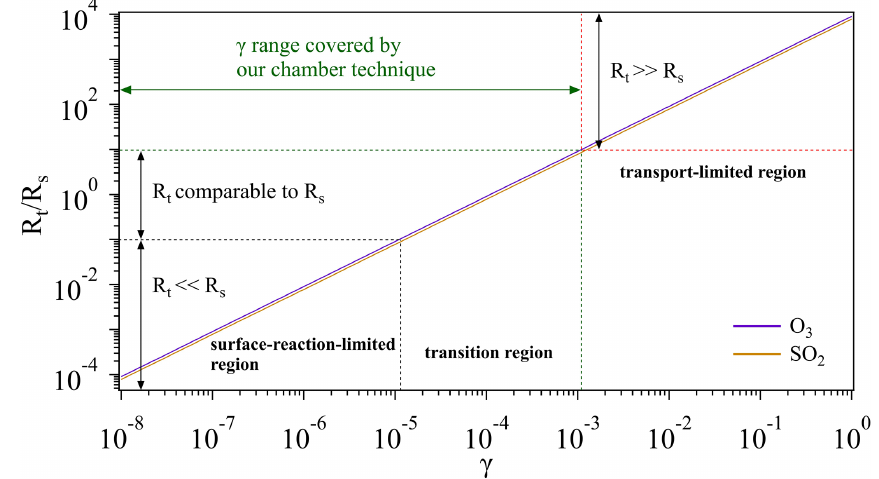
Figure 8. Schematic of different regions for O 3 and SO 2 uptake. Note that we artificially define the case when R t /R s < 0 . 1 (i.e., 1 order of magnitude lower) as the surface-reaction-limited region ( R t (cid:28) R s ) and the case when R t /R s > 10 (i.e., 1 order of magnitude higher) as transport-limited region ( R t (cid:29) R s ). And the case in between is defined as the transition region, where R t is comparable to R s . The transport resistance R t is calculated based on the measured average V t (Sect. 3.1.3). Calculations for the surface resistance R s are referred to conditions of room temperature (296K) and